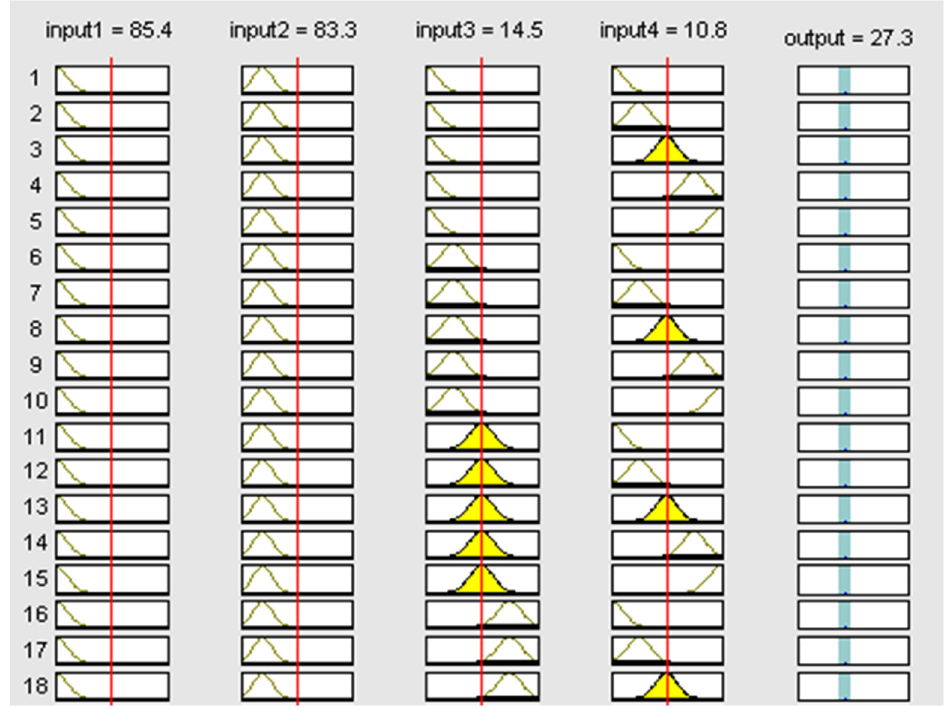
Figure 9. Partial fuzzy rules.